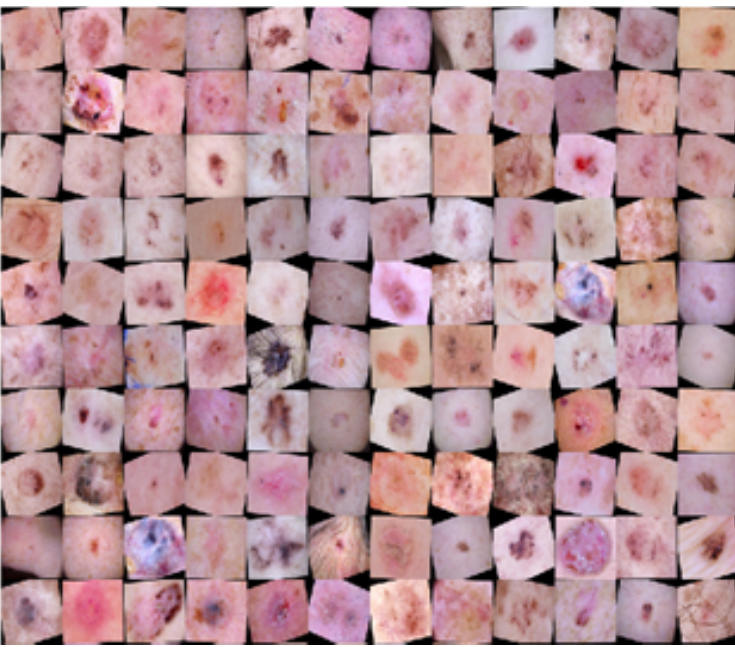
Figure 2. Augmented data samples using translation, rotation, and